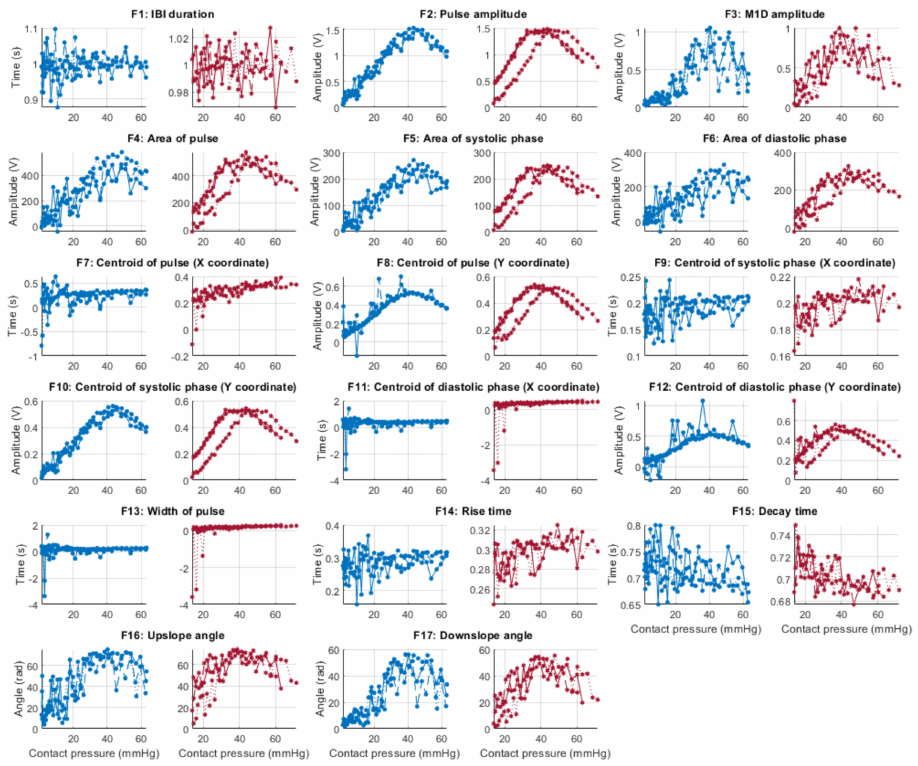
Figure 8. Behaviour of the extracted features during stage 1 hypertension when compared against contact force. Blue lines: Infrared PPG-derived features. Red lines: Red PPG-derived